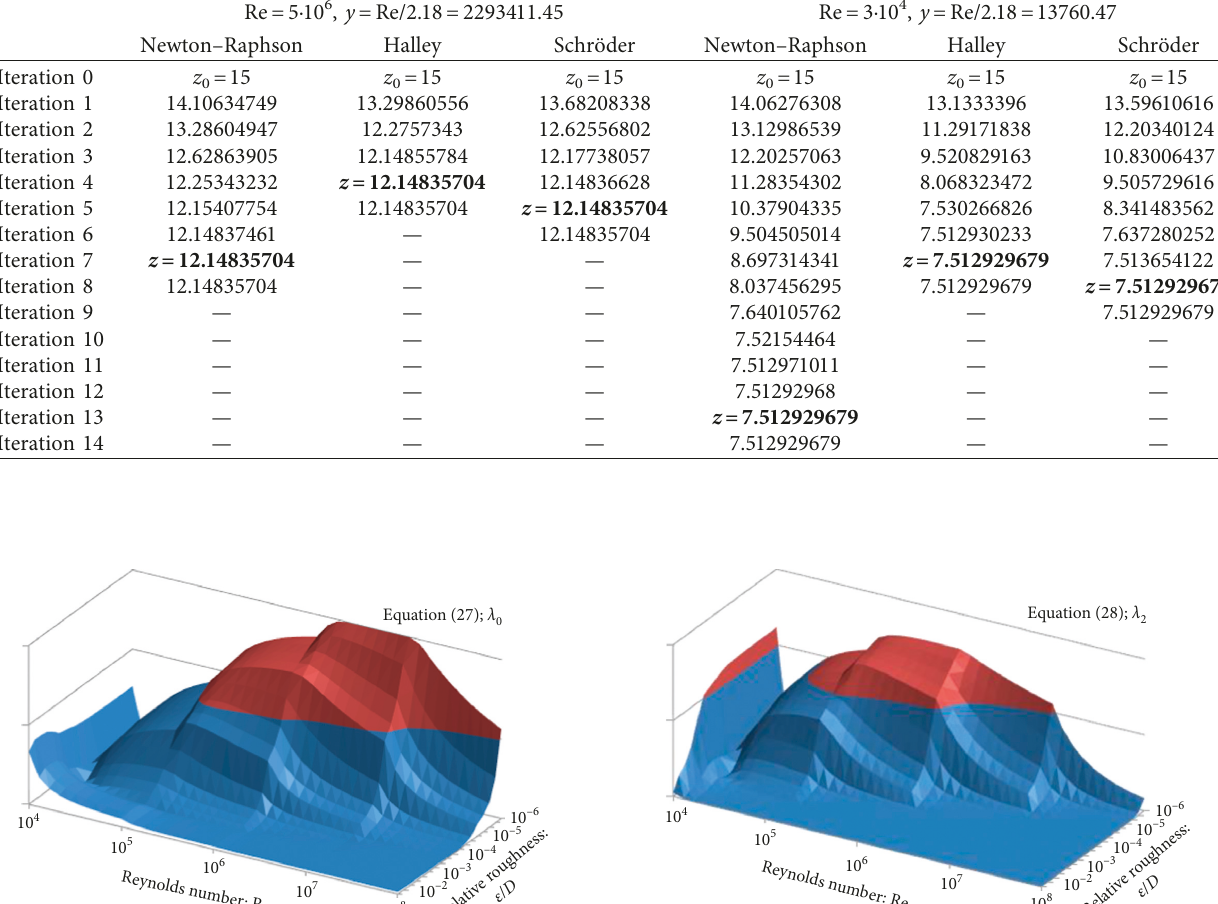
Table 10: Calculation of W(y) where y